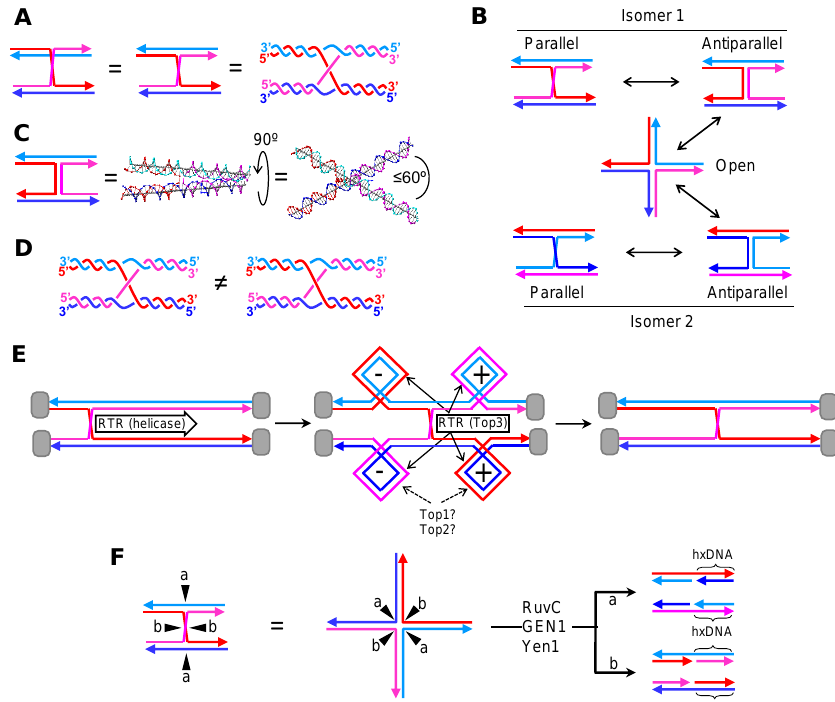
Figure 2. Features of the canonical Holliday junction (cHJ). ( A ) Classical 2D schematics of a cHJ in the parallel conformation. Left: Watson and Crick strands are depicted as straight lines, with the Watson strand on the top in each molecule. Center: the strands of the upper molecule are vertically flipped so the cross-join is easier to visualize. Right: a plectonemic drawing of the strands whereby the double helix of the DNA can be inferred more easily. ( B ) The cHJ can exist as two isomers, which depend on the pair of strands that forms the cross-join. Each isomer can adopt two extreme conformations, parallel and antiparallel. An open planar conformation serves as an intermediate between isomers and conformers. ( C ) The antiparallel conformation with tilted arms in the most thermodynamically favored stereoisomer. The antiparallel conformer is depicted as straight lines (left), or modelled with Nanoengineer-1 on the same XY plane (center) and after turning 90° on the Z-plane (right). ( D ) The spatial position of the strands in the cross-join results in different topoisomers. On the left, the Watson strand of the upper molecule crosses under the Watson strand of the lower molecule. On the right, the crossing plane is inverted. ( E ) Branch migration in topologically constrained molecule ends (grey boxes) results in positive (+) supercoiling ahead and negative (−) supercoiling behind. The putative activities of the RTR complex in each step are indicated (helicase or topoisomerase). Top3 could deal with supercoiling alone or with the aid of Top1 and/or Top2. ( F ) The Holliday junction is removed by resolvases by a nicking and counter-nicking mechanism. Two cutting planes are feasible (“a” and “b”). In the open conformation, each plane should have the same chance, so that two distinct products are equally possible. Resolution of a single cHJ gives rise to two new molecules with one flank identical to the parental DNAs and the other flank with cross annealing of Watson and Crick strands coming from different parental DNAs—i.e., heteroduplex DNA (hxDNA). Curly brackets mark out the hxDNA region in each product. Blueish lines, Crick strands; reddish lines, Watson strands. Dark (blue, red) and light (cyan, pink) colors are also included so that the four strands can be differentiated. Parental dsDNA anneals a light and a dark strand, either cyan with red or pink with blue; whereas hxDNA anneals either light–light (cyan–pink) or dark–dark (red–blue) strands. The arrowhead indicates the 3′ end. The equal sign links different visual schematics of the same molecule.